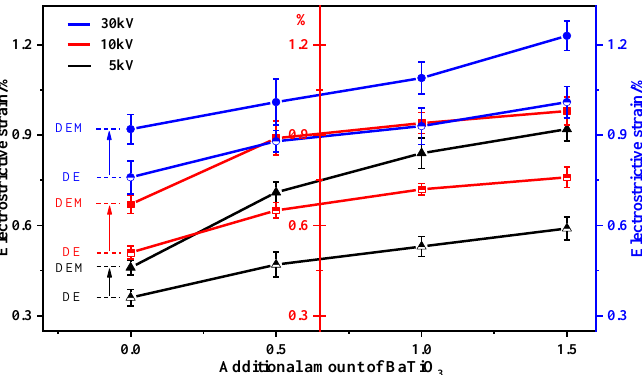
Figure 6. Comparison diagram of electrostrictive strain between two kinds of samples. 0.0